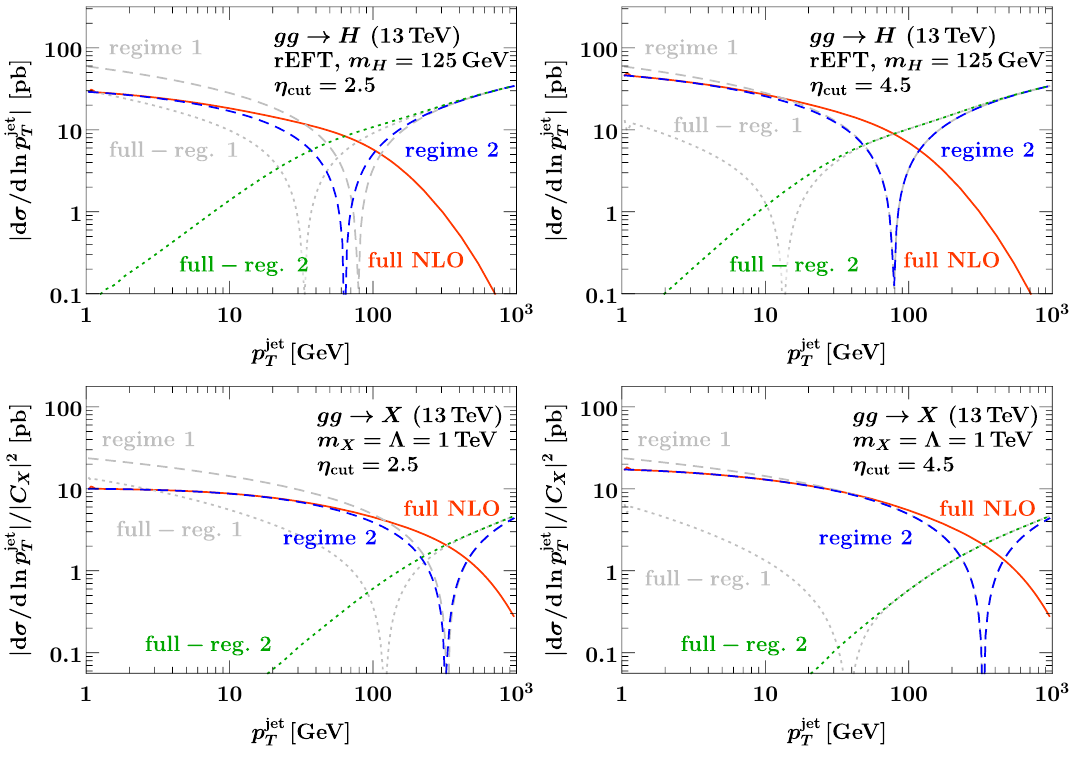
Figure 4 . Comparison of singular and nonsingular contributions to the (cid:12)xed ( (cid:11) s ) (LO 1 ) p jet T O spectrum with rapidity cut (cid:17) jet < (cid:17) cut for gg H (top row) and gg X (bottom row), (cid:17) cut = 2 : 5 j j ! ! (left) and (cid:17) cut = 4 : 5 (right). The orange solid lines show the full results, the dashed blue lines the regime 2 results with (cid:17) cut dependent beam functions, and the dotted green lines their di(cid:11)erence. The dashed and dotted gray lines show the corresponding regime 1 results, which do not